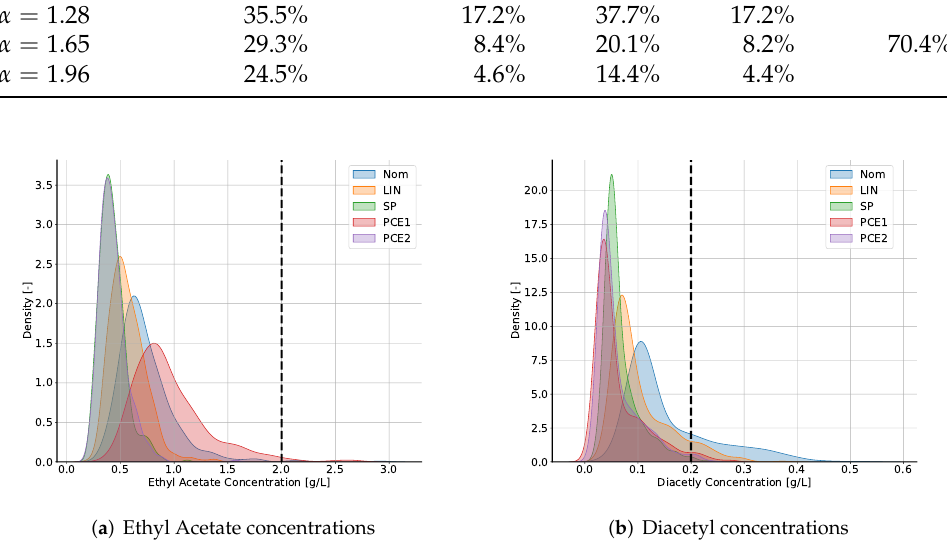
Figure 7. Density plots for concentrations of ethyl acetate and diacetyl based on Monte Carlo simulations for optimal trajectory obtained with minimising time. The vertical dashed line depicts the concentration